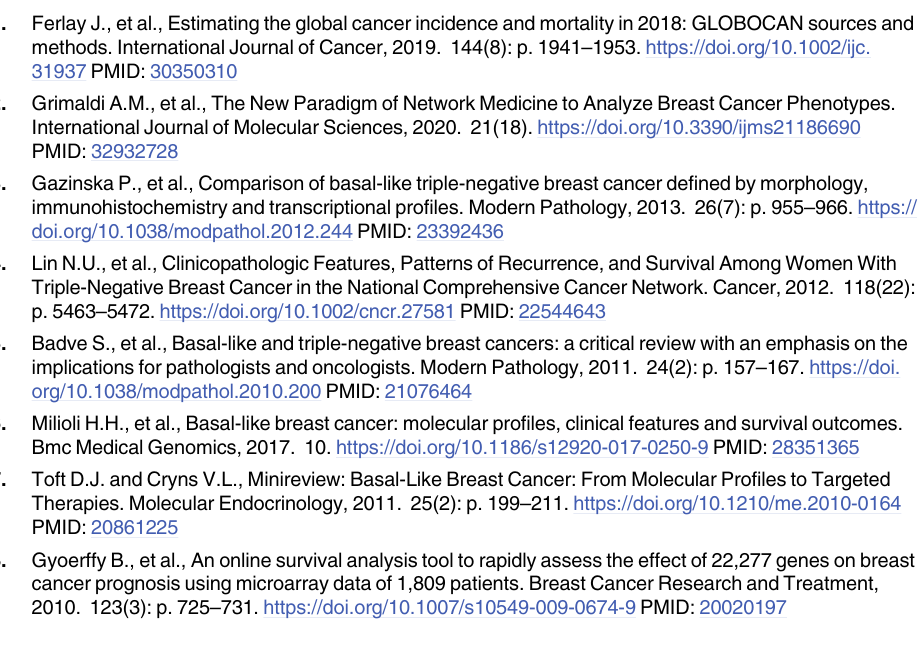
S1 Table. Basal-like specific switch genes. The table is composed of two separated sheets. The first sheet reports the complete list of 108 switch genes found to be specific for basal-like breast cancer subtype. The second sheet reports the complete list of 11 switch gene whose activation was found to be associated with the worst prognosis from the KM survival analysis on the TCGA breast invasive carcinoma patients. S2 Table. CNVs results. The table reports the results of the CNVs data analysis for the 11 basal-like prognostic